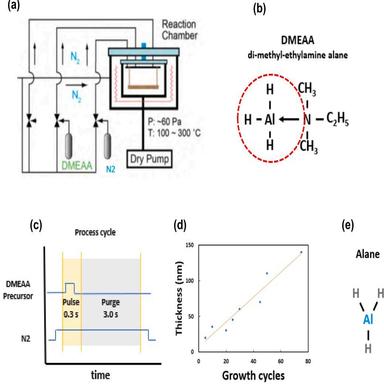
(a) A schematic illustration of the ALD process consisting of precursor of DMEAA and N2-gas as input, and chamber reaction conditions of: Pressure = 60 pa; and temperature = 100–300 ◦C; (b) DMEAA molecule, as Al is not directly bonded to any C-atoms; (c) process cycle of AlH3 thin film growth over time with pulse time (0.3 s) and purge time (3 s); (d) linear growth versus number of cycles; and (e) the final form of deposited AlH3 molecule of thin film.